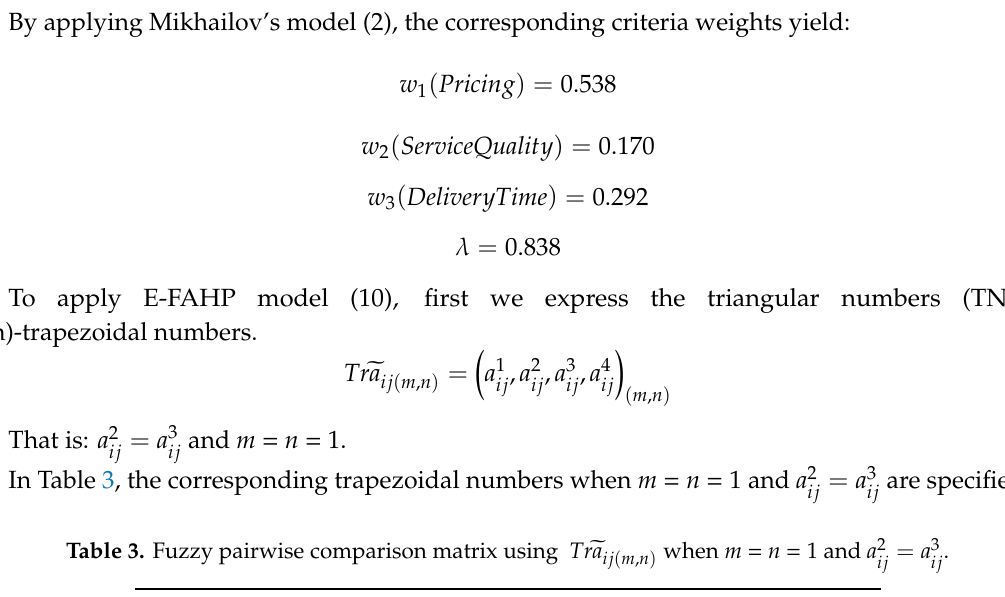
Table 3. Fuzzy pairwise comparison matrix using Tr (cid:101) a ij ( m , n ) when m = n = 1 and a 2